Question: Write a descriptive caption for this figure.
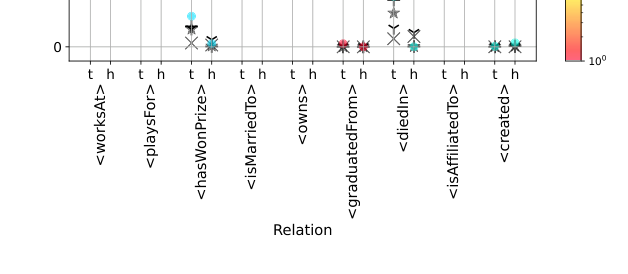
Answer: Test MRRs for each relation and direction (“t” means tail and “h” head, respectively) for (a) ICEWS14 (top) and (b) YAGO (bottom). Colors indicate the number of queries for relation and its direction in the test set.